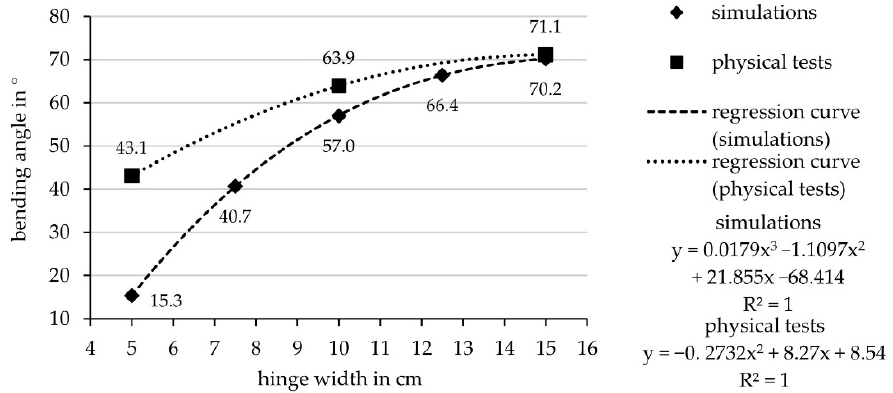
Figure 13. Regression formula with a polynomic approximation curve based on the results of the simulations and the physical tests.